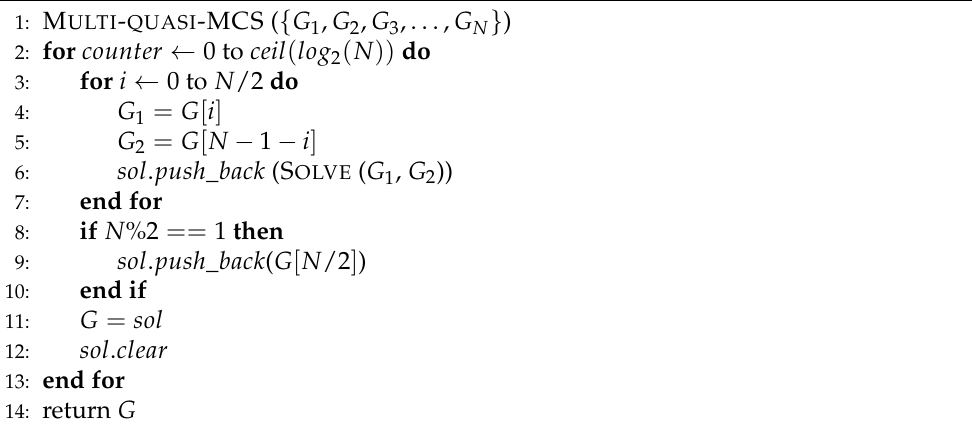
Algorithm 4 The tree approach: increasing the parallelism of the waterfall